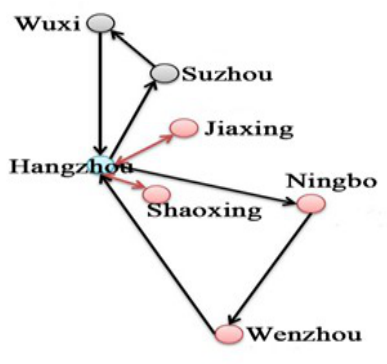
Figure 3(1). The Final Optimization